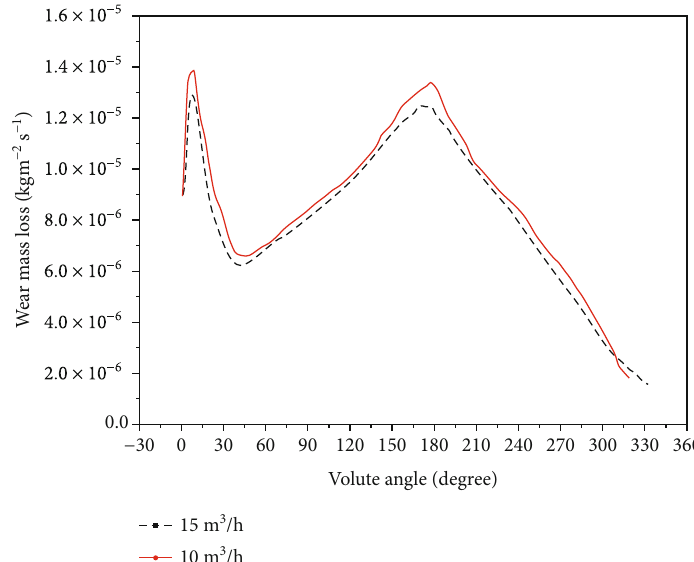
Figure 6: Variation in wear along the outer casing wall at two fl ow rates for the solid-liquid mixture of 5%concentration (by volume).